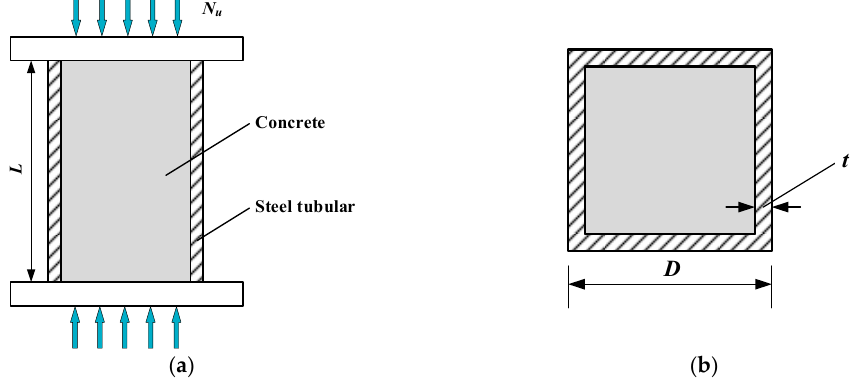
Figure 1. Schematic diagram of the axial compression test device for square concrete-filled steel tubular (CFST) short columns: ( a ) front view; ( b ) section view of the specimen.